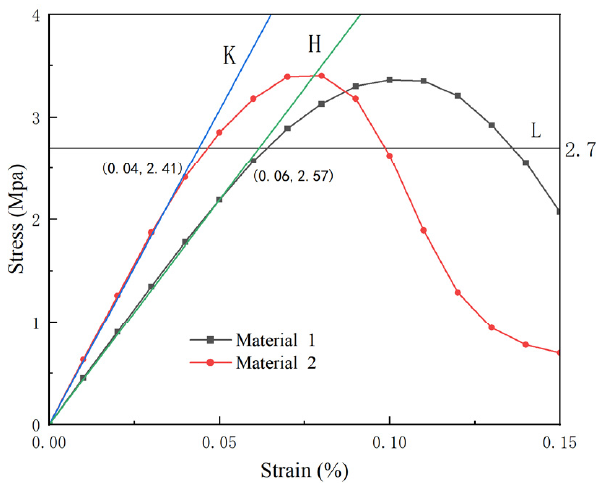
Figure 18. Comparison of elastic and plastic stages.